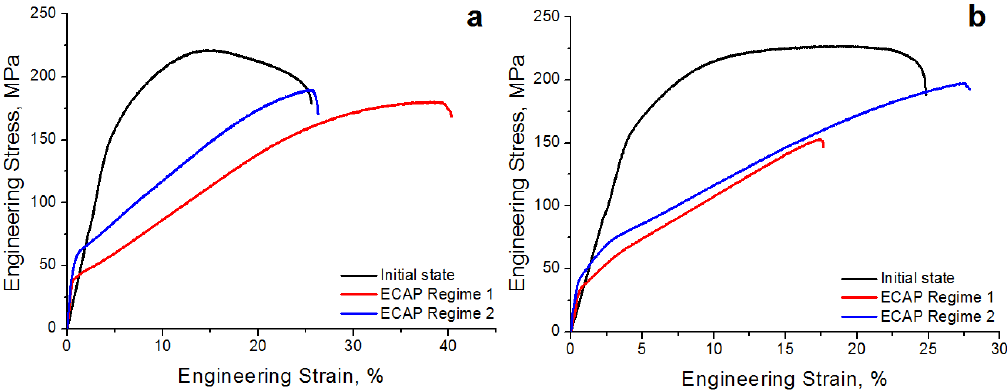
Figure 3. Engineering stress–strain response of Mg-2.0%Ag ( a ) and Mg-4.0%Ag ( b ) alloys before and after ECAP.